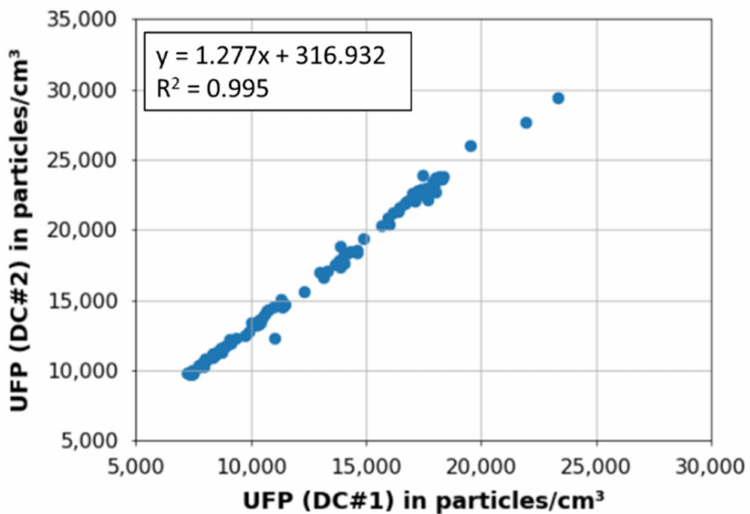
Figure 17. Comparison of the UFP device (DC#2) with the reference device